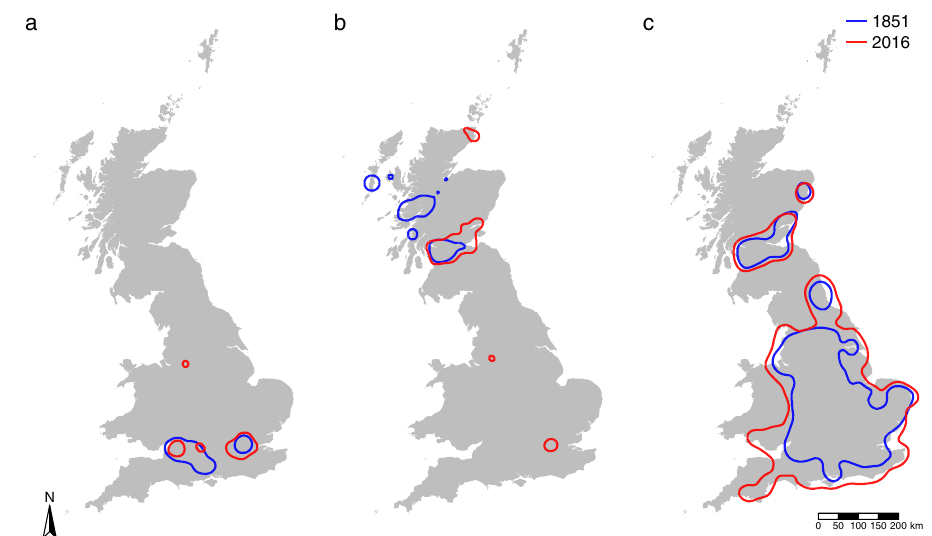
Fig. 1 Surname concentrations. Kernel density estimates (KDEs) of the 1851 and 2016 population-weighted geographic distributions of bearers of the family names ( a ) Offer; ( b ) McPhee; and ( c ) Smith. Regional names manifest urban and inter-urban migration over time, while very common names mirror the GB-wide population distribution. (Note: KDEs provide measures of relative density, weighted by the general population density. They are range standardised to improve comparability using the method detailed in ref. 12